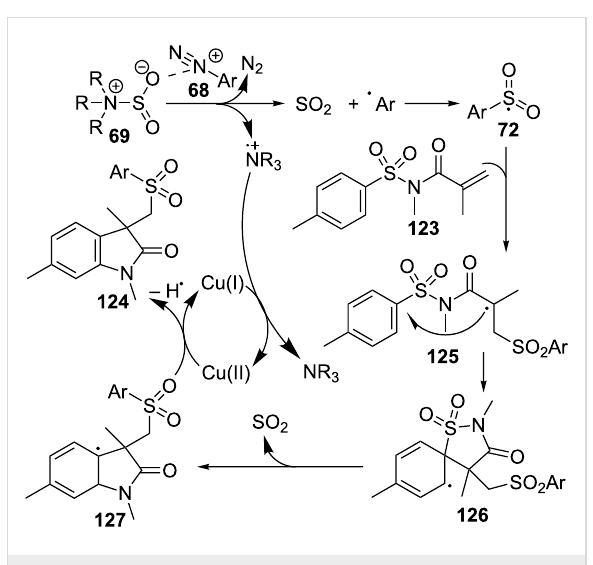
Scheme 36: Proposed mechanism for the preparation of oxindoles 124